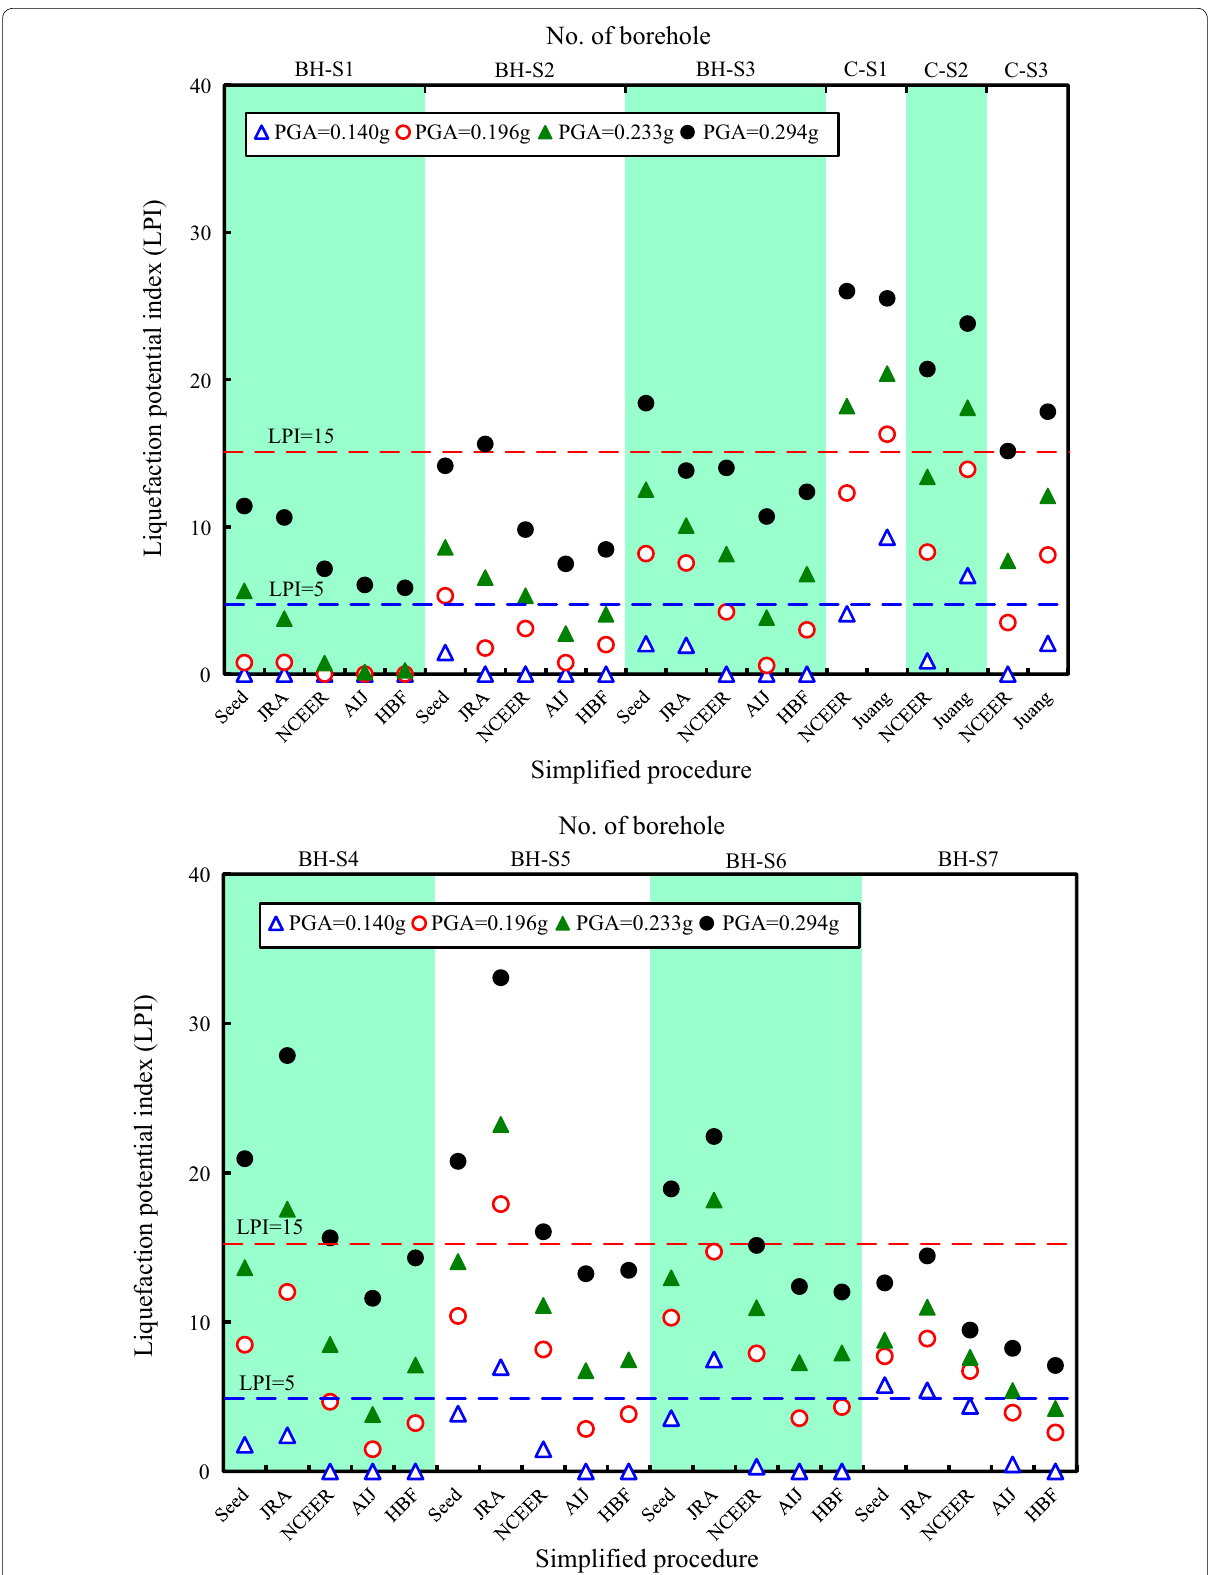
Fig. 10 Evaluated LPI for the Sinshih District by different simplified methods and